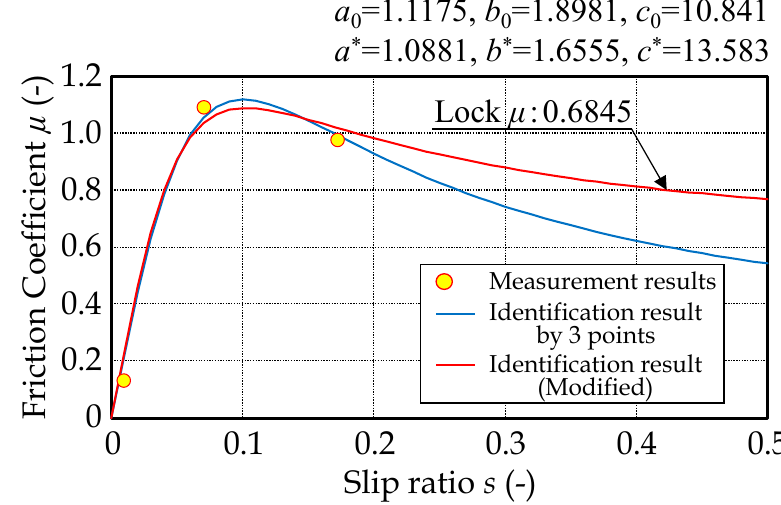
( b ) Figure 17. Pavement surface used for measurement. The measurement and identification results on each road surface are shown. First, the result of the fine particle asphalt mixture is shown in Figure 18. Three points represent the measurement results and the blue line represents the result of identification by the MF